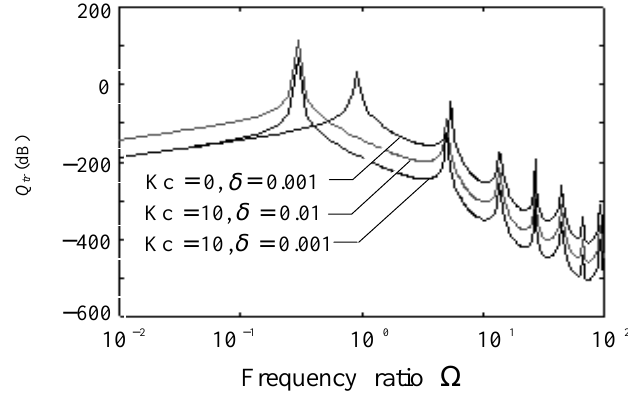
Fig. 6. Power flow control effects influenced by the damping of the receiver ( µ = 0 . 4 ,ω 1 /ω 0 = 5 ,γ = 2 ,ξ = 0 . 01